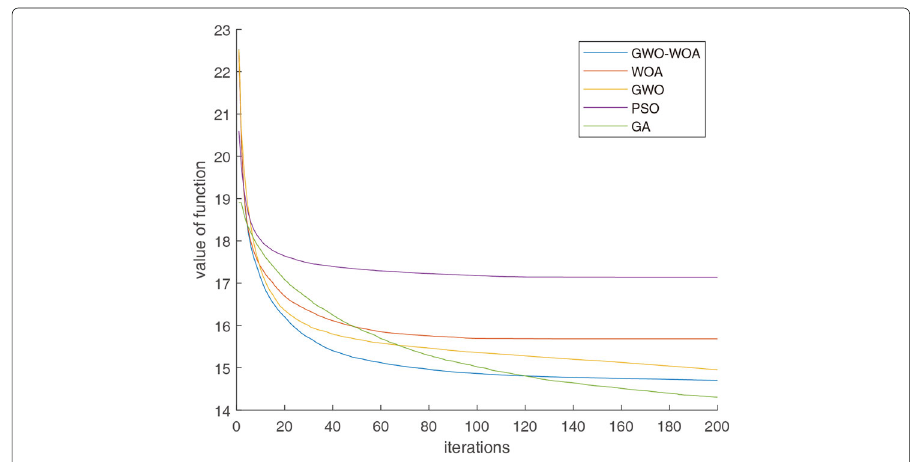
Fig. 1 Convergence curve of algorithms when device number is 60